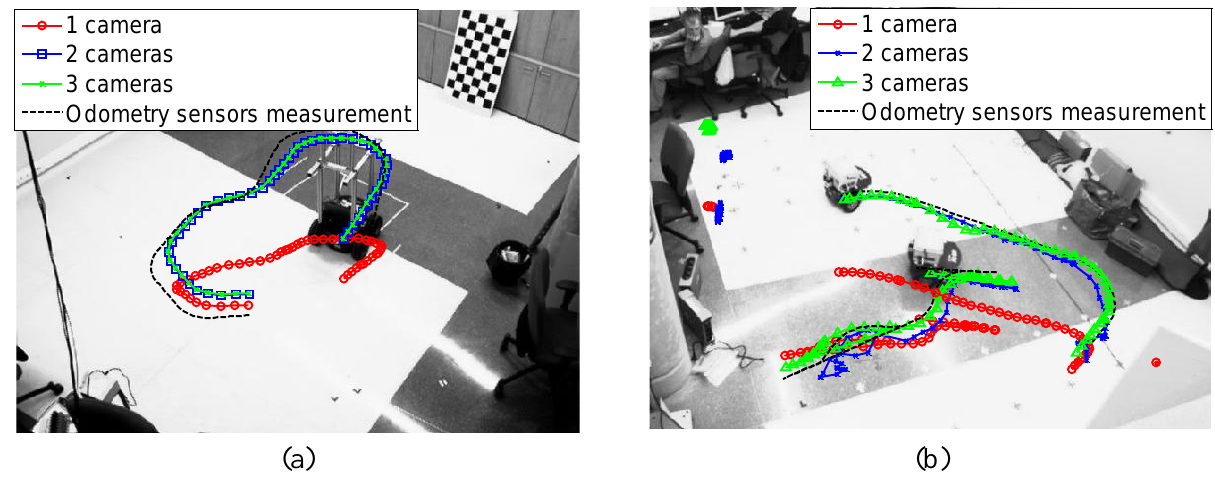
Figure 11. 3D trajectory estimated by the algorithm and measured by the odometry sensors on board the robots on the X